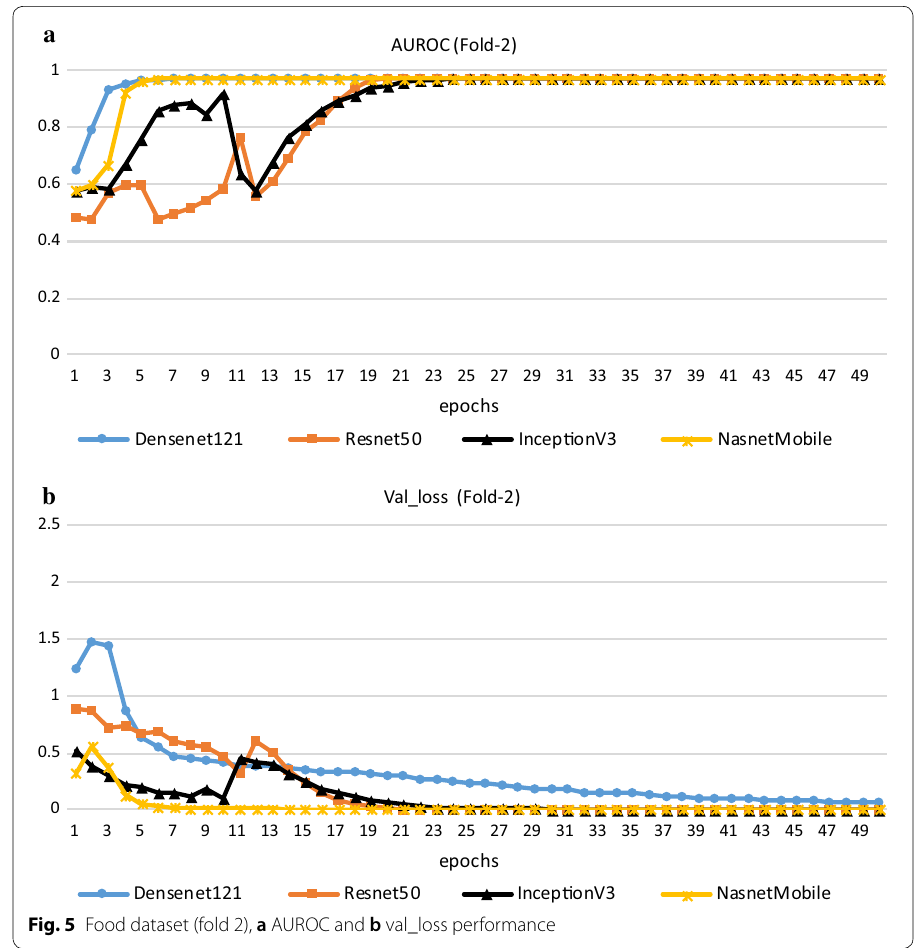
Fig. 5 Food dataset (fold 2), a AUROC and b val_loss